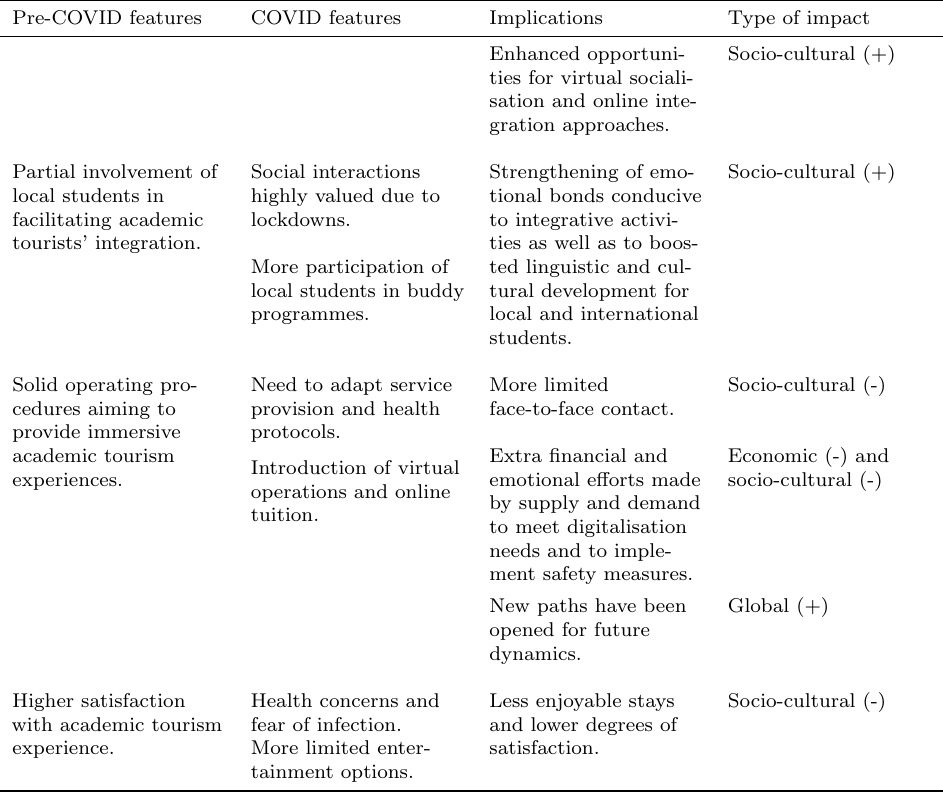
Table 6: Effects of COVID-19 pandemic on academic tourism in Barcelona (continued) Pre-COVID